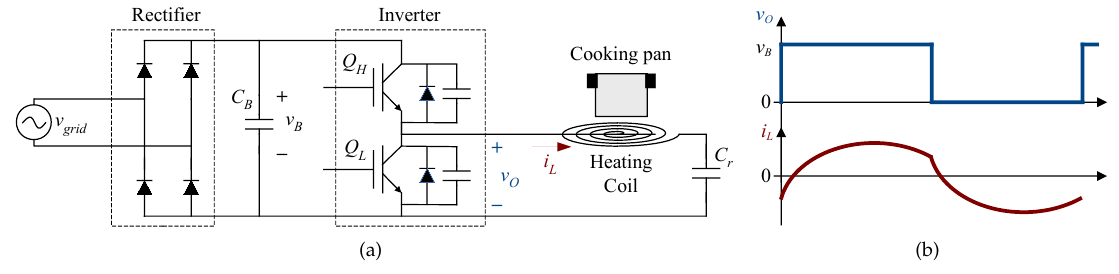
Figure 2. Domestic induction heating power converter: ( a ) Schematic. ( b ) Output